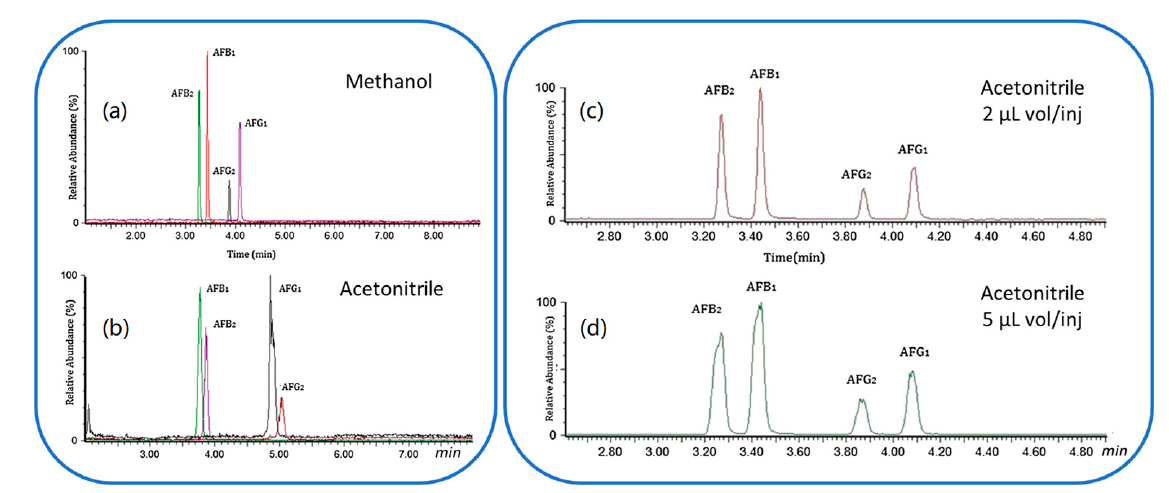
Figure 5. On the left, the effect of the modifier on the AFs elution order, ( a ) methanol and ( b ) acetonitrile; on the right, the effect of different volume injection on the peak shape using only acetonitrile, ( c ) 2 µ L ( d ) 4 µ L. Modified and reprinted with the permission of [158].